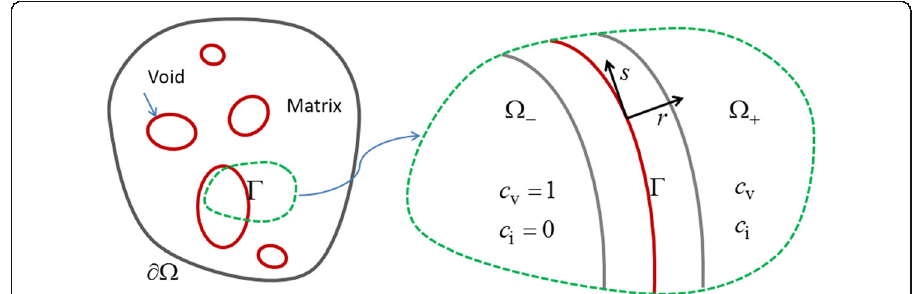
Fig. 1 A schematic of the diffuse interface and the local coordinate system used in the asymptotic analysis of model